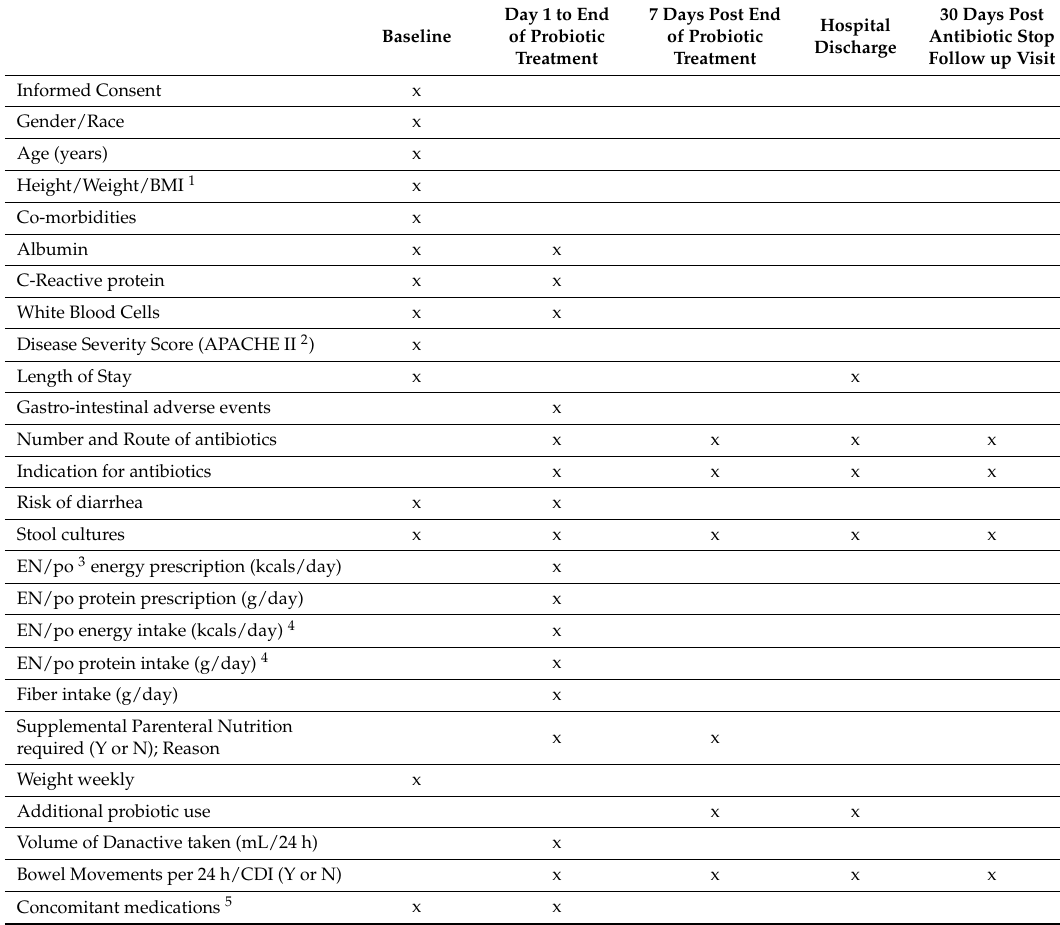
Table A1. Tool used for Data